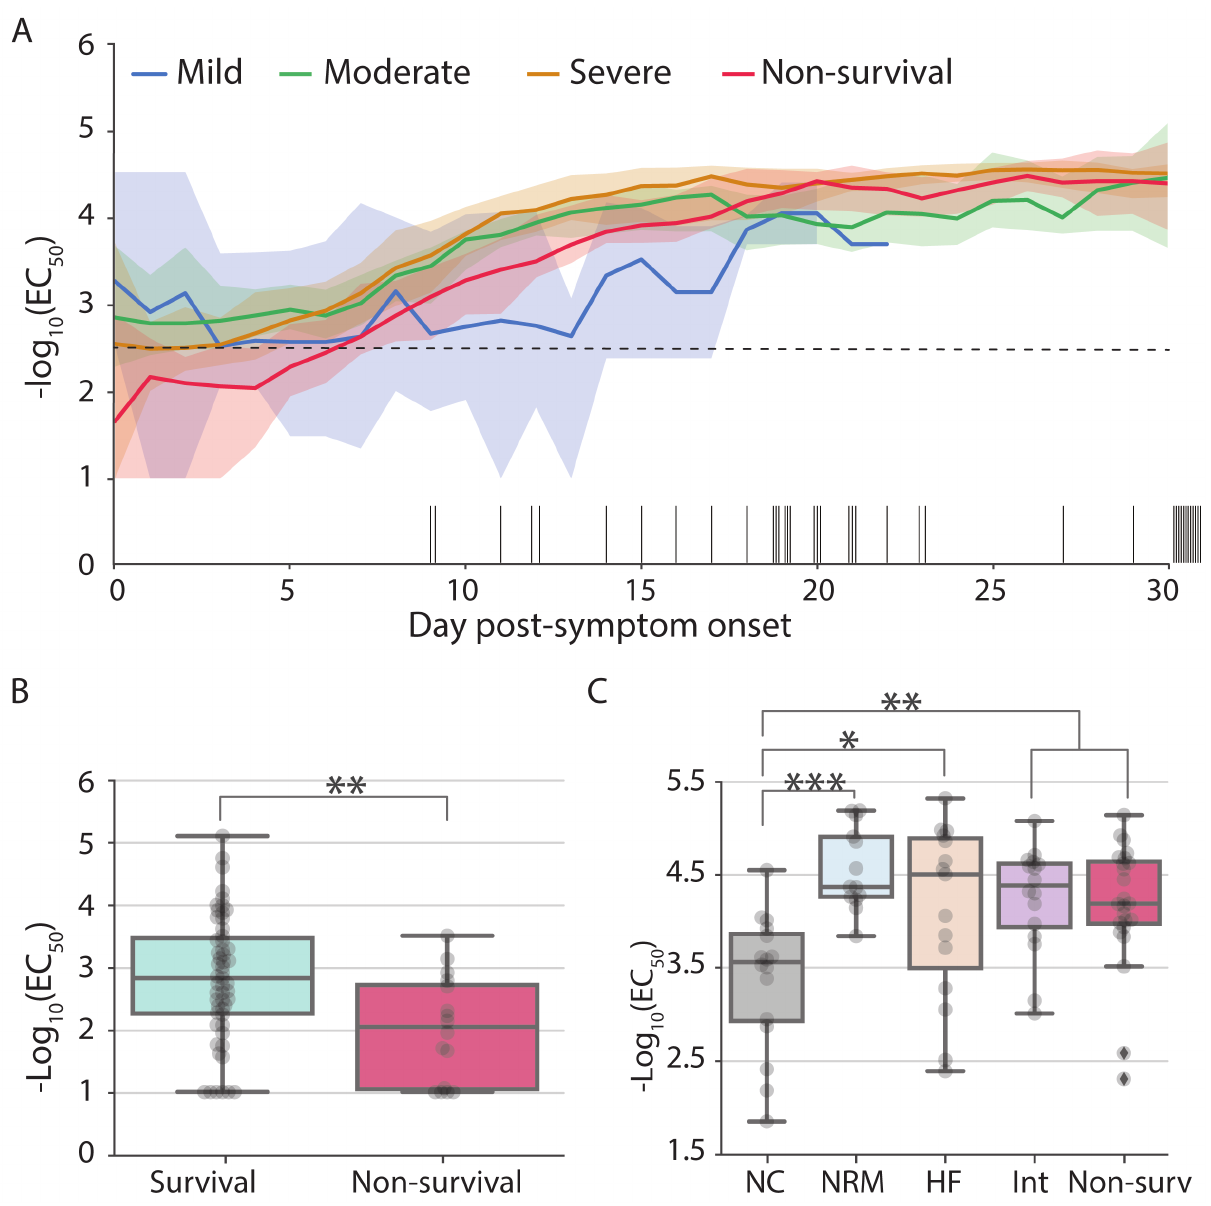
Fig 3. IgG titers are associated with mortality early post-symptom onset and with severity of disease later during hospitalization. (A) Median IgG titer at a given day during hospitalization by disease severity: mild (blue), moderate (green), severe (orange) and non-survivors (red). Back bars on the x- axis describe the day of death for each deceased patient. For clarity purposes, only the first 30 days of hospitalization are shown (blood samples were collected up to day 60 PSO). Shaded areas correspond to the 90% confidence intervals. IgG positivity threshold is indicated with a horizontal black dotted line at -log 10 (EC 50 ) = 2.5. We define “day post-symptom onset" (PSO) as the day relative to the patient-reported onset of symptoms. (B) IgG titers for survivors (cyan) and non-survivors (red) at day 4 PSO (used here to represent the statistical differences observed between convalescent and deceased patients from days 3 to 8). (C) Box-plot at day 18 PSO (representative day of the statistical differences observed from days 18 to 24) describing IgG titers (-log 10 EC 50 ) by patient outcome: survival patients requiring oxygen supplementation (nasal canula: grey, non-rebreather mask: blue; high-flow: salmon; intubation: pink) and non-survival patients (red). Boxes extend from the 25 th to 75 th percentiles, whiskers extend to the lowest and highest data point within 1.5 interquartile range of the lower and upper quartiles, the middle line corresponds to the median. Statistical significance is denoted with asterisks (Mann-Whitney; � p < 0.05, �� p < 0.01).